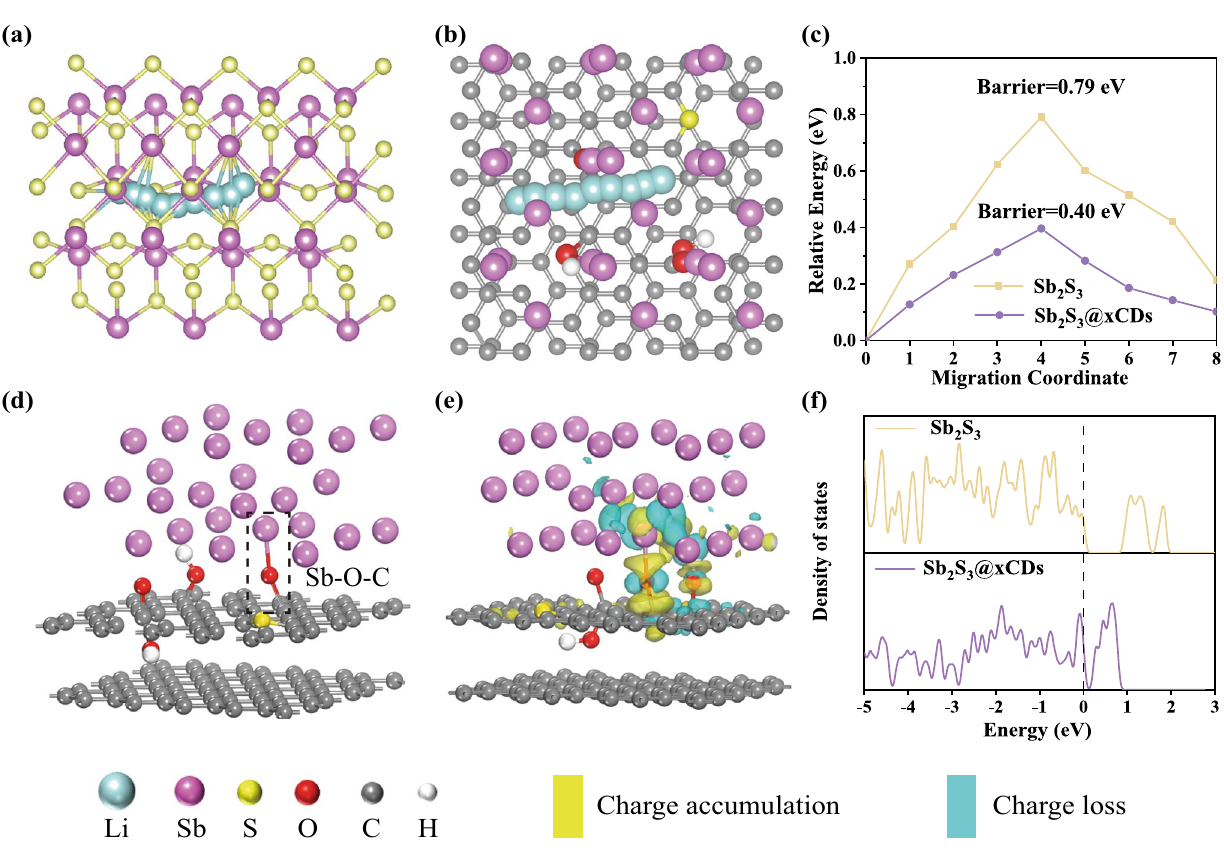
Fig. 11 DFT calculations. Li + -ion migration pathway of a stibnite Sb 2 S 3 and b Sb 2 S 3 @0.1CDs hybrids in the front view. c Comparison of Li + -ion diffusion energy barrier between stibnite Sb 2 S 3 and Sb 2 S 3 @xCDs. d Structure of the Sb–O–C bond. e Charge density difference plot of Sb 2 S 3 @xCDs. The light blue and yellow areas indicate the electron loss and accumulation, respectively. f Density of states (DOS) profiles of stibnite Sb 2 S 3 and Sb 2 S 3